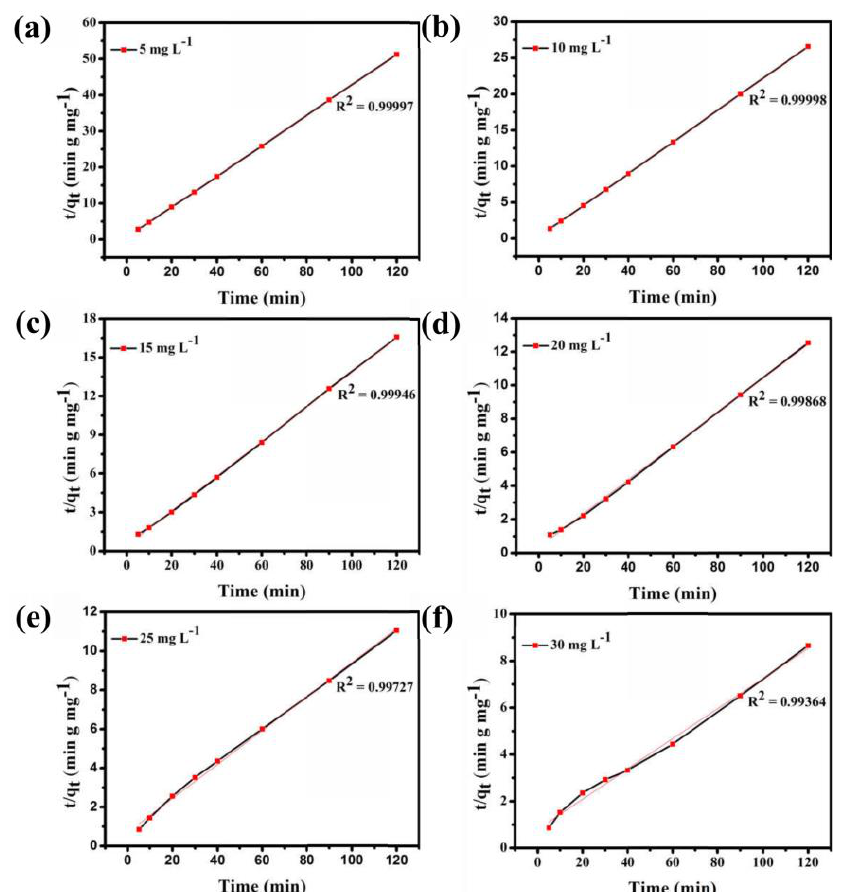
Figure 9. ( a – f ) Pseudo-second-order adsorption of MB at various initial concentrations in solution.